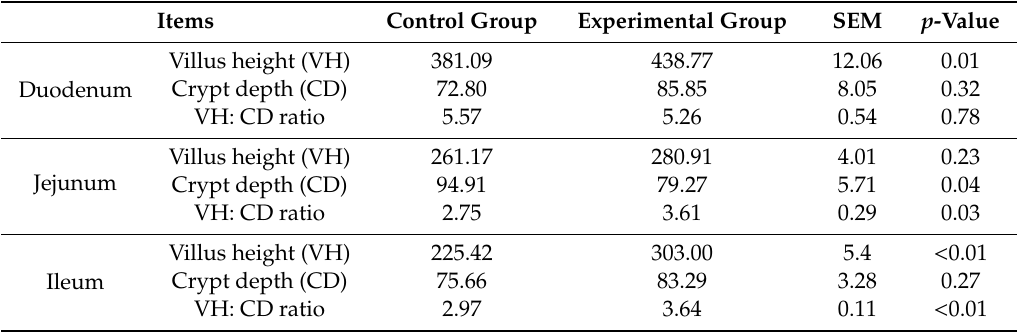
Table 6. E ff ect of oral administration with B. amyloliquefaciens on the intestinal morphological structures of